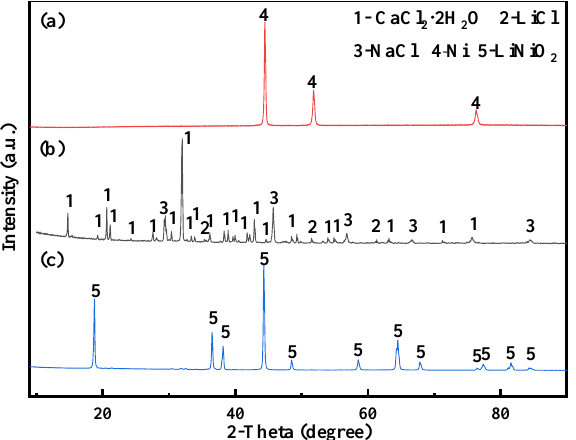
Figure 20. ( a ) XRD pattern of the product after 10 h of 0.18 A constant current electrolysis ( b ) XRD pattern of molten salt near cathode after electrolysis ( T = 750 °C) ( c ) XRD analysis of LiNiO 2 in mol- ten salt.